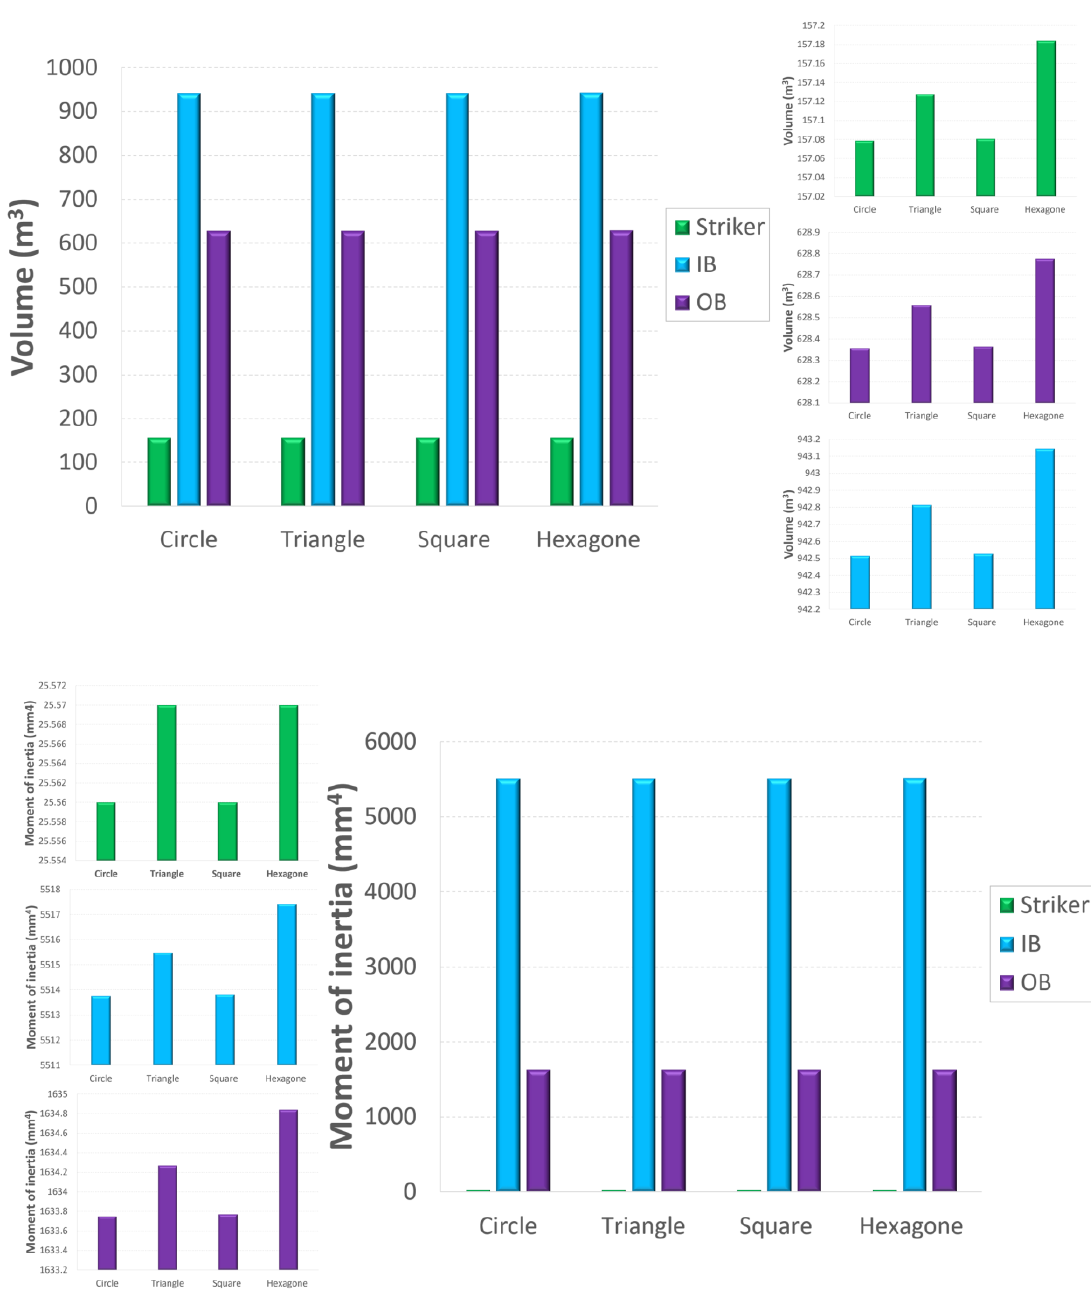
Figure 16. Evolution of the geometrical parameters of the SHPB system.